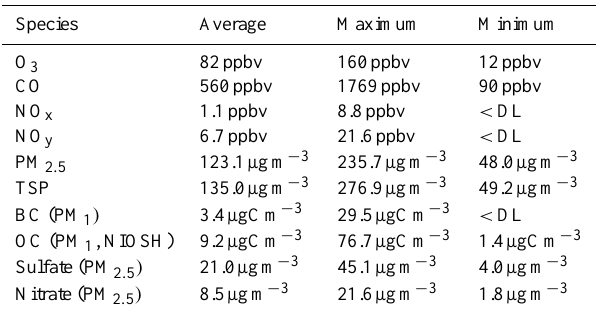
Table 3. Average, maximum, and minimum concentrations of O 3 , CO, NO x , NO y , PM 2 . 5 , TSP, BC and OC, sulfate, and nitrate at the summit of Mt. Tai in June 2006.